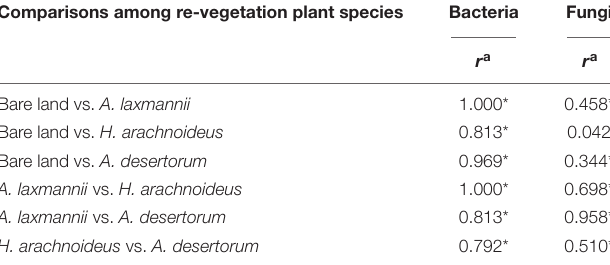
TABLE 3 | Analyses of similarity (ANOSIM) for bacterial and fungal communities among bare land and different re-vegetated plant species based on abundance considering Bray-Curtis dissimilarity matrices.